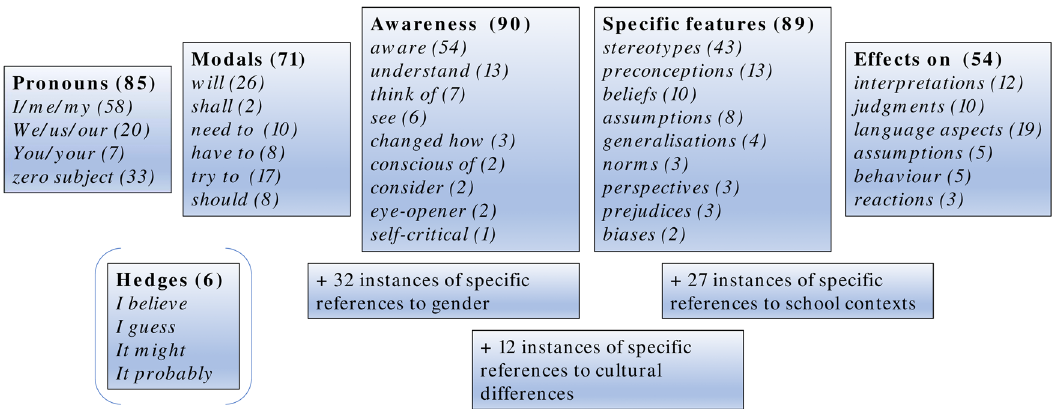
Figure 3: Overview summary of constituents in responses to the question “ What will you take with you from this “ experiment ” and the following discussions into your future profession? ” ( n = 118